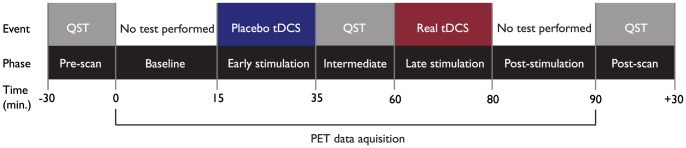
Experimental design used in the second PET scan.Placebo tDCS was applied during the early PET phase (15 to 35 min post-tracer administration) and real tDCS during the late PET phase (60 to 80 min). QST was performed before the PET, in the period between placebo and real tDCS and immediately after the PET.